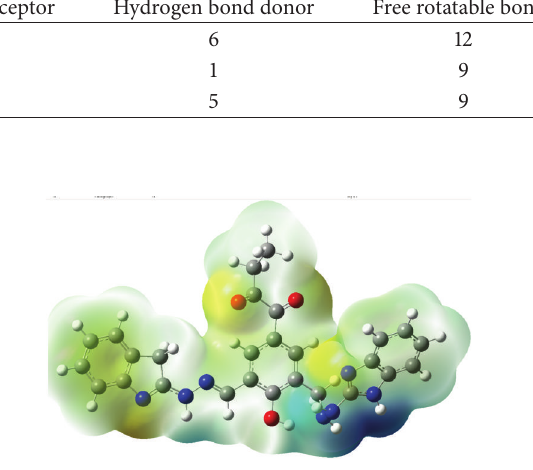
Figure 11: Electrostatic potential maps (ESP) of Ligand 19 at M06/6- 31g(d) level in gas phase (scale: −0.867 ∗ 10 −2 to 8.67 ∗ 10 −2